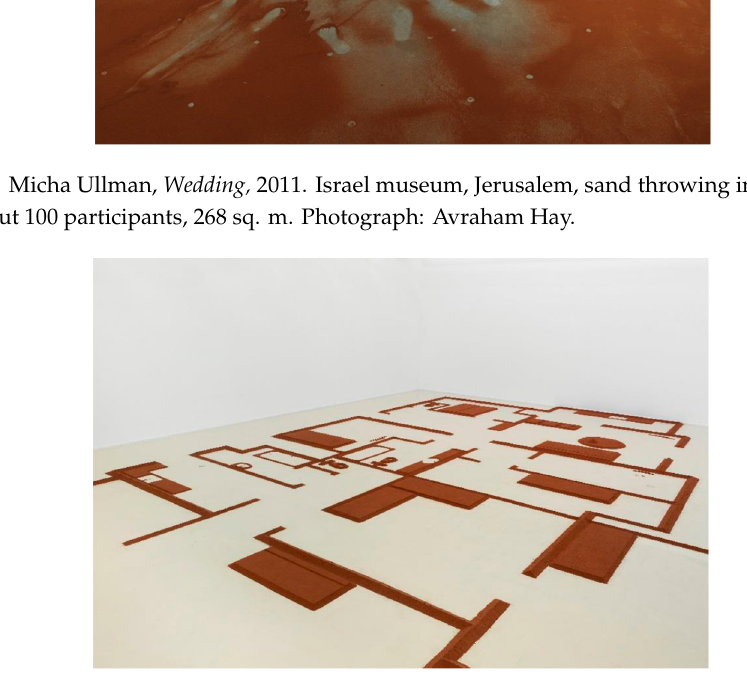
Figure 13. Micha Ullman, Semidetached , 2018. Earth installation presented at Scene of Events exhibition, Herzliya Museum of Contemporary Art, 2018. Red sand, 6 cm × 1470 cm × 2000 cm. Photo: Avraham Hay.